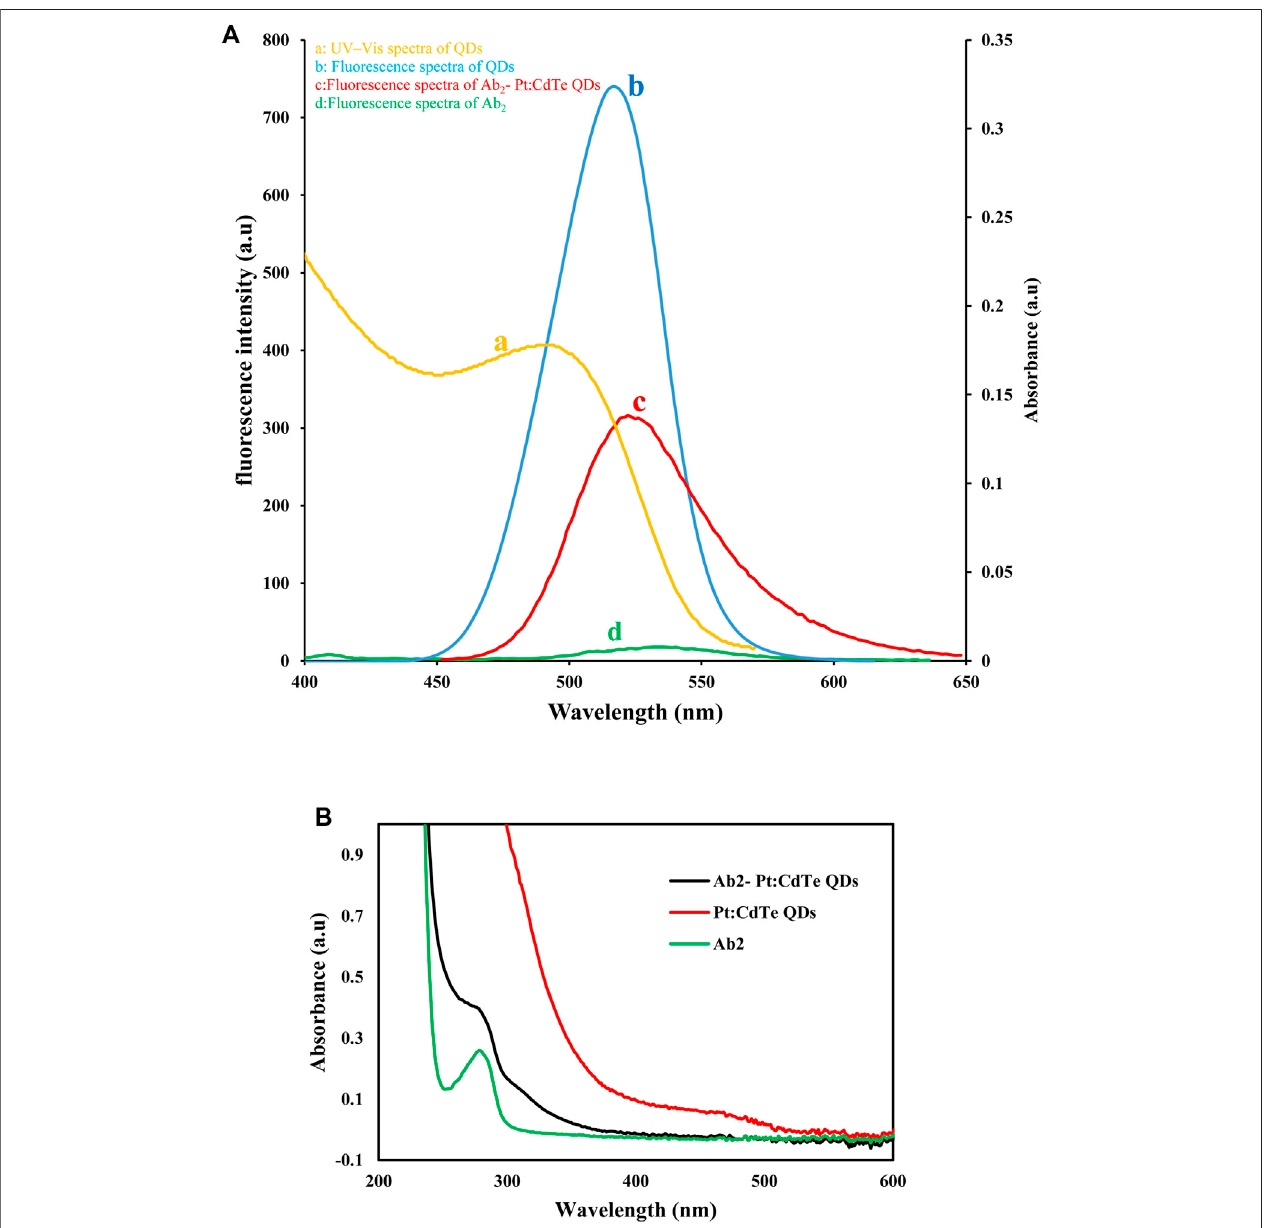
FIGURE 3 | UV – Vis spectra of QDs and Fluorescence spectra of QDs and Ab 2 - Pt:CdTe QDs.